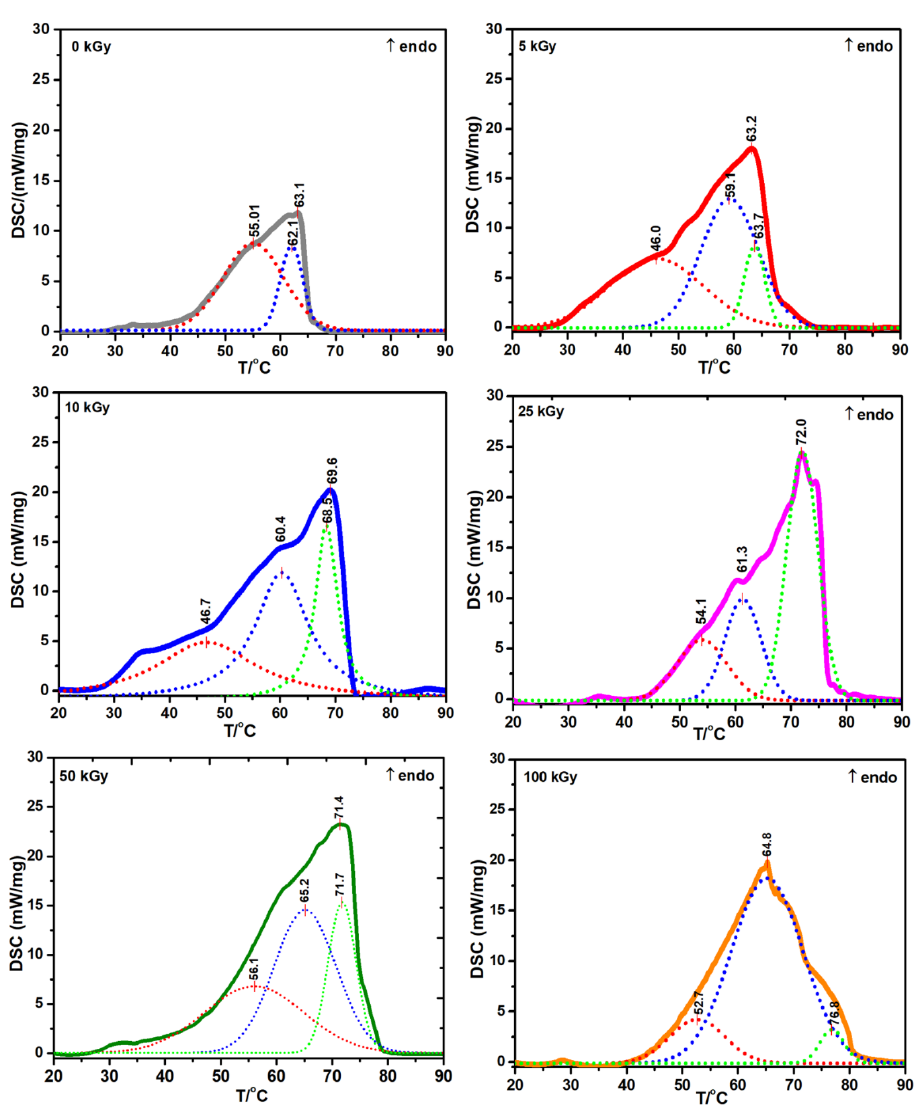
Figure 7. DSC curves for crosslinked collagen hydrogel.